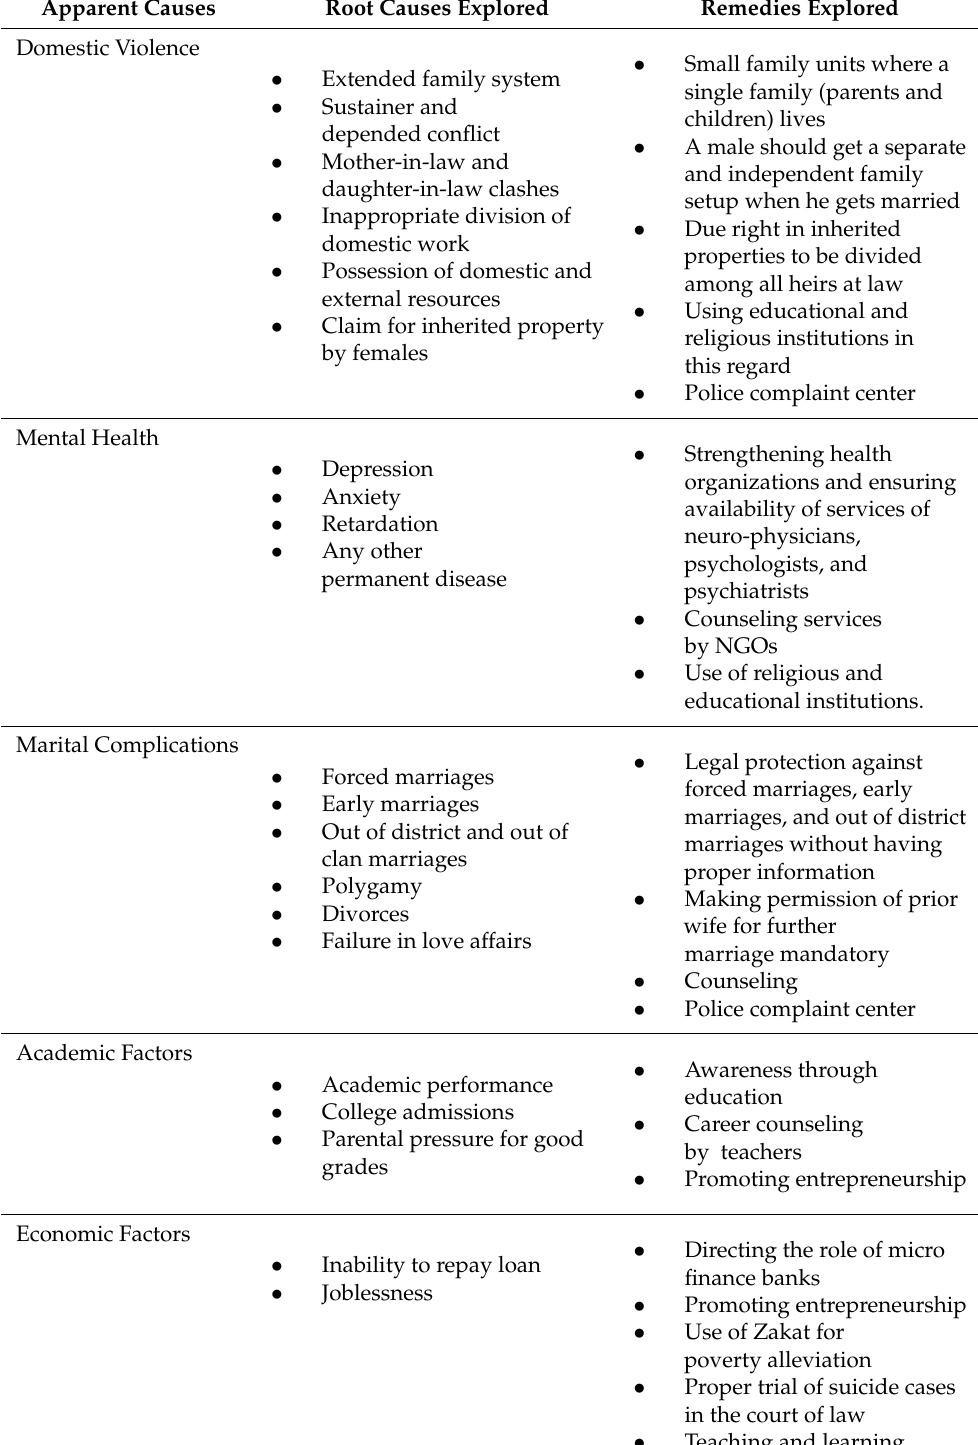
Table 1. Summary of the interview